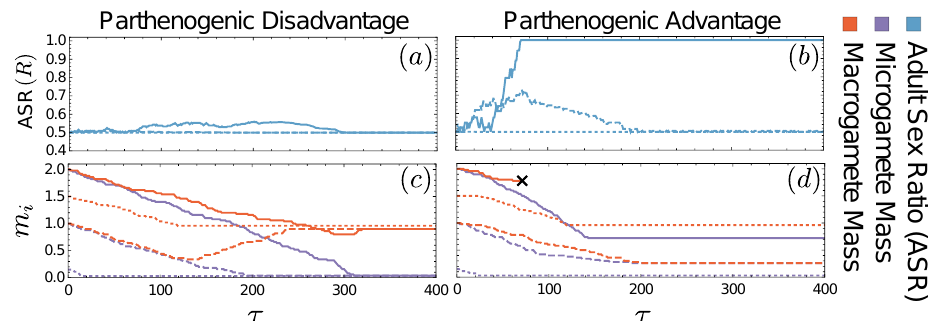
Figure 2. Two examples of evolutionary dynamics without mutations to asexuality. Panels ( a , c ): Parthenogenetic disadvantage with β p = 1.3 > β z = 1. Panels ( b , d ): Parthenogenetic advantage with β p = 0.7 < β z = 1. The different line types correspond to different initial conditions: solid line, ( m x , m y ) = ( 2,2 ) ; dashed lines, ( m x , m y ) = ( 1,1 ) ; dotted lines, ( m x , m y ) = ( 1.5,0.2 ) . ( a , b ) The adult sex ratio (ASR), i.e., the proportion of adults producing microgametes, deviates little from an even (50:50) ratio in ( a ) but has alternative stable equilibria in ( b ), including 100% microgamete production and extinction of the macrogametes. In ( a , c ), all starting conditions lead to the same evolutionary stable anisogamous state with minimally small microgametes m y = | δ m | and m x = 1. In ( b , d ), different initial conditions lead to distinct evolutionary stable states: ( m x , m y ) = ( 2,2 ) → ( × ,0.7 ) ; ( m x , m y ) = ( 1,1 ) → ( 0.4,0.4 ) ; ( m x , m y ) = ( 1.5,0.02 ) → ( 1, | δ m | ) , where crosses denote extinction